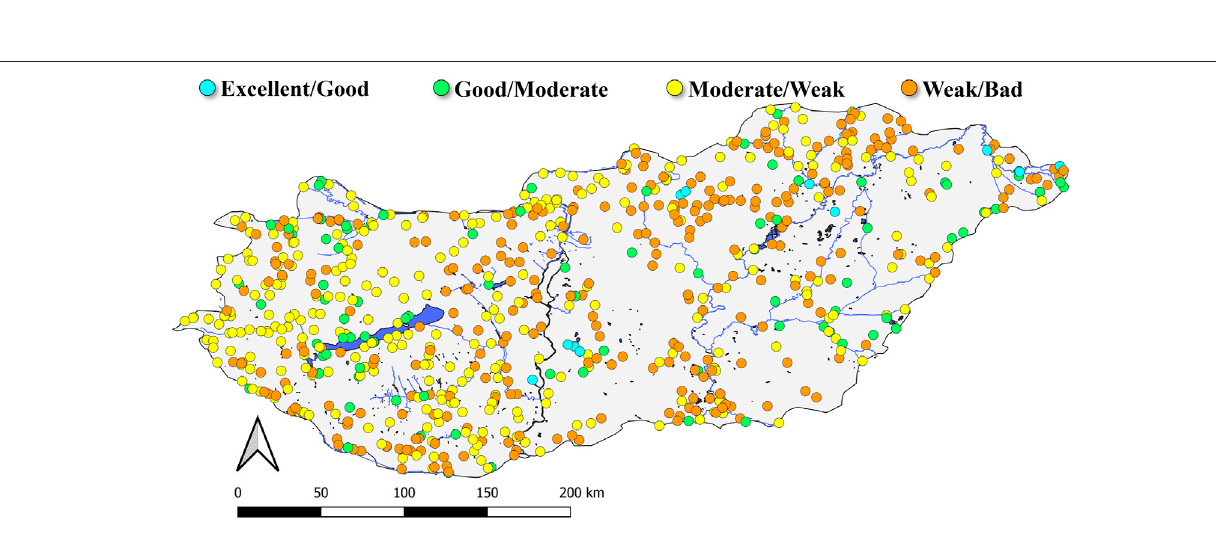
Frontiers in Environmental Science |